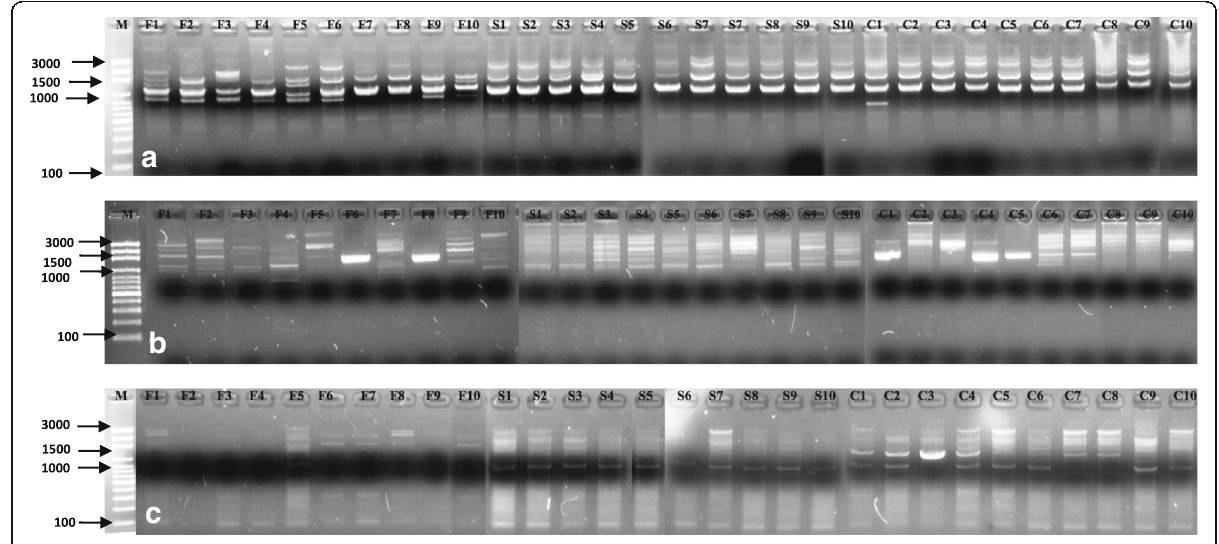
Fig. 4 RAPD patterns of three growth forms of Dendrocalamus strictus generated by primer OPA 11 ( a ), OPA 19 ( b ) and OPA 20 ( c ). M-Molecular weight ladder (100 bp); F1 – F10 = FRI campus, S1 – S10 = Shivpuri range and C1 – C10 = Chiriapur range